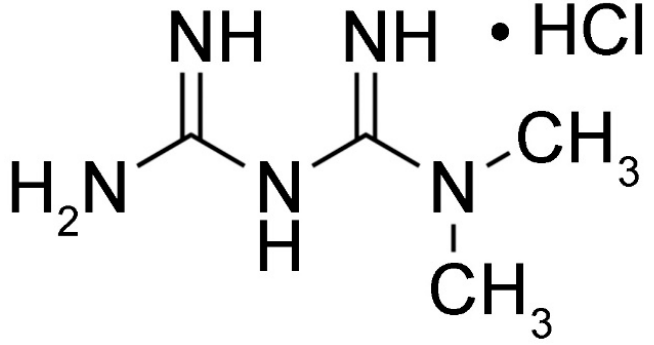
Figure 2. Structure of metformin.